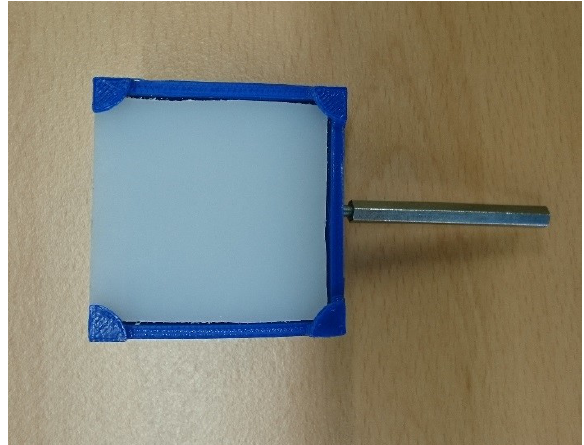
Table 1. LDA classifier test